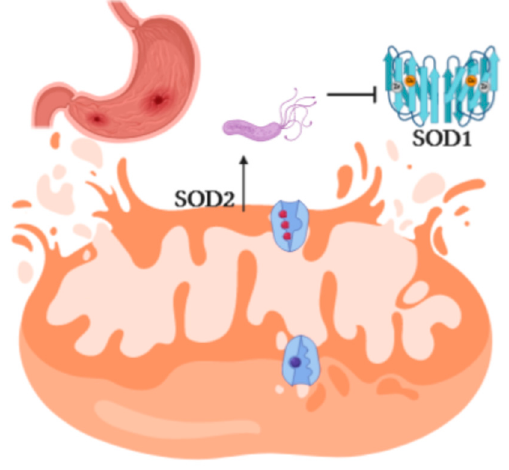
Figure 4. Schematic representation of superoxide dismutase 1 ( SOD1 ) and superoxide dismutase 2 ( SOD2 ) genes modulated by Hp . Downregulation of SOD1 and upregulation of SOD2 point out the involvement of mitochondria in ROS production.